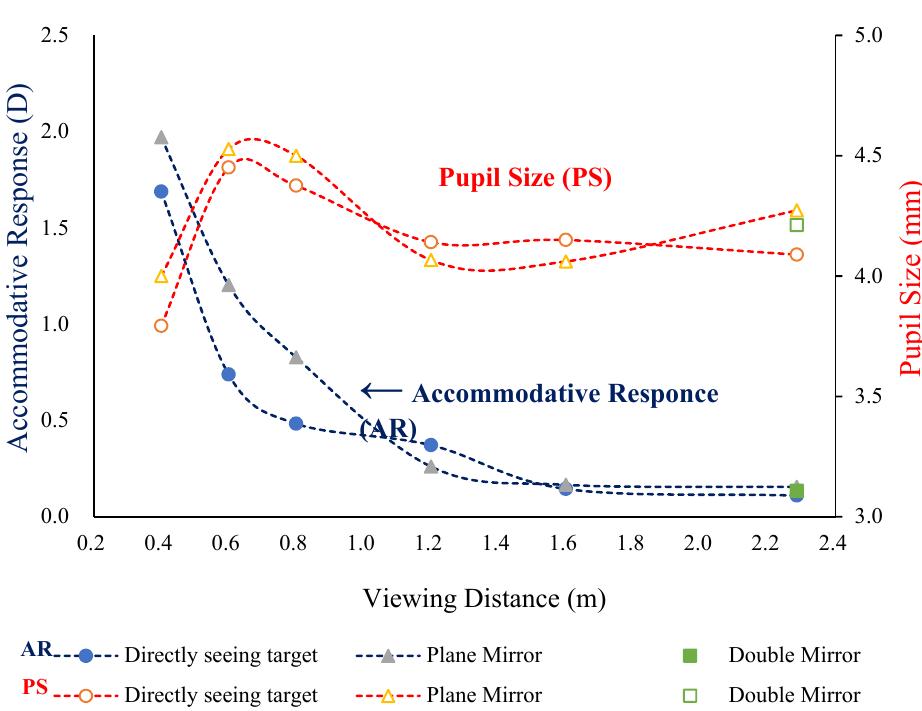
Figure 5. Dependence of the accommodative response and pupil size on the viewing distance with (1) directly seeing the real object, (2) seeing the virtual image through a single plane mirror, and (3) seeing the virtual image at 2.285 m through the double-mirror system. A solid circle, a solid triangle and a solid square represent the accommodative response, while a hollow circle, a hollow triangle and a hollow square represent the pupil size corresponding to (1–3).